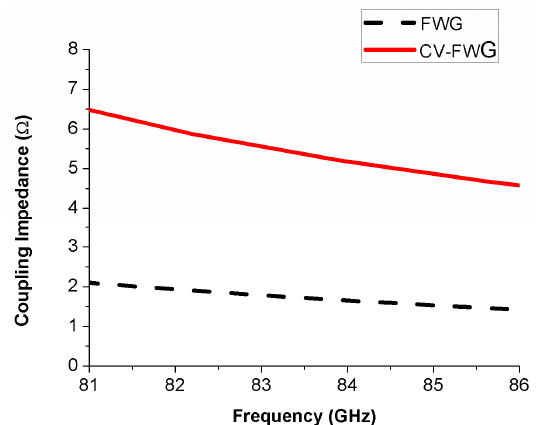
Figure 11. Coupling impedance of CV-FWG and conventional FWG.